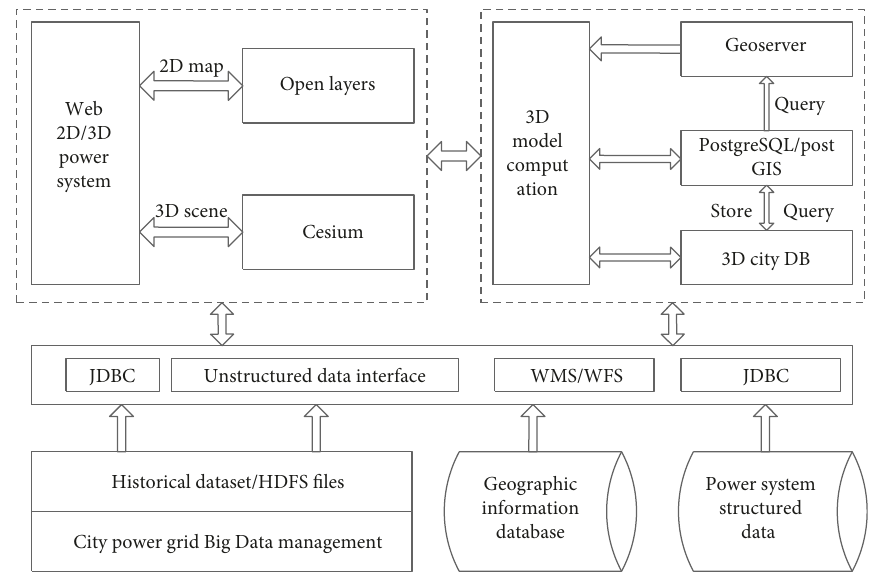
Figure 7: Framework of the 3D display system.